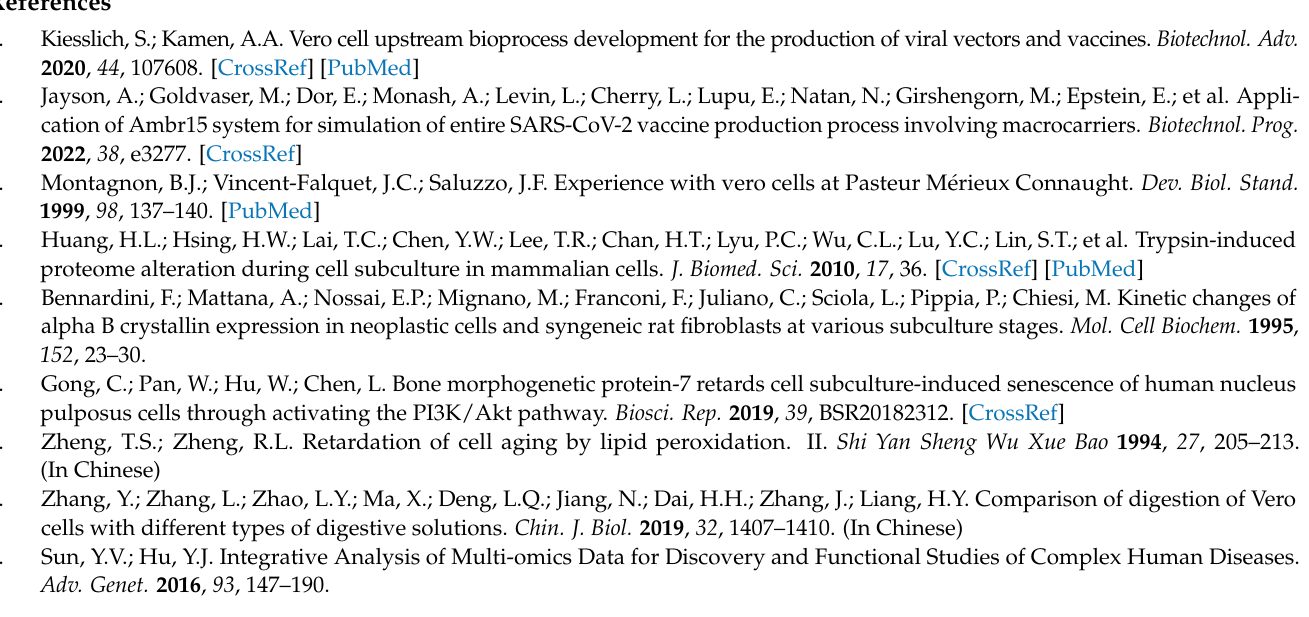
Figure S4: Analysis of protein expression level; Figure S5: Combined analysis of transcriptomics and proteomics; Table S1: List of differentially expressed RNAs, proteins, and